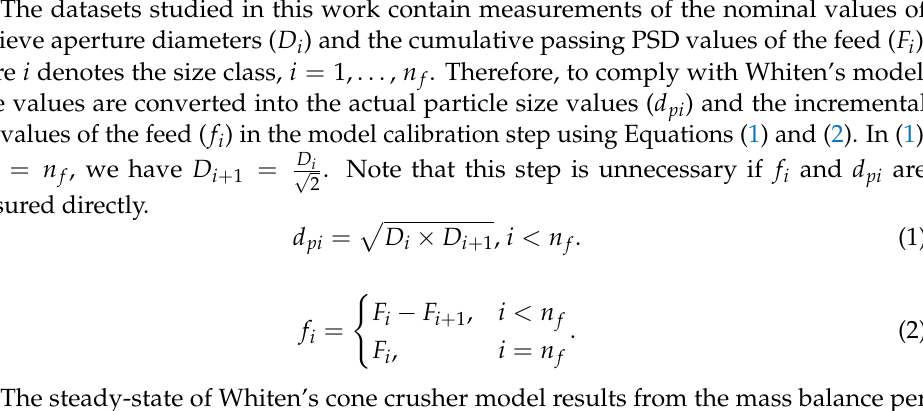
Figure 2. Block diagram representation of the cone crusher